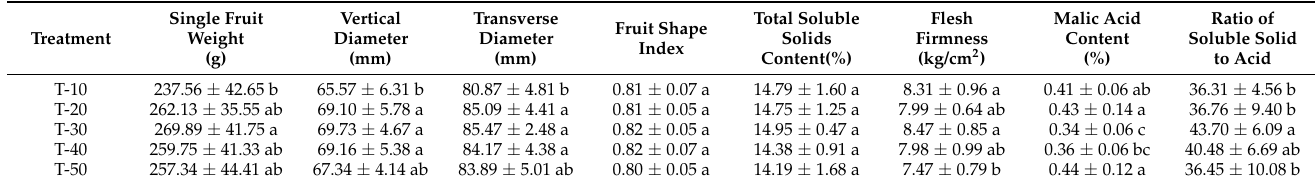
Table 6. Effects of interstock length on fruit quality